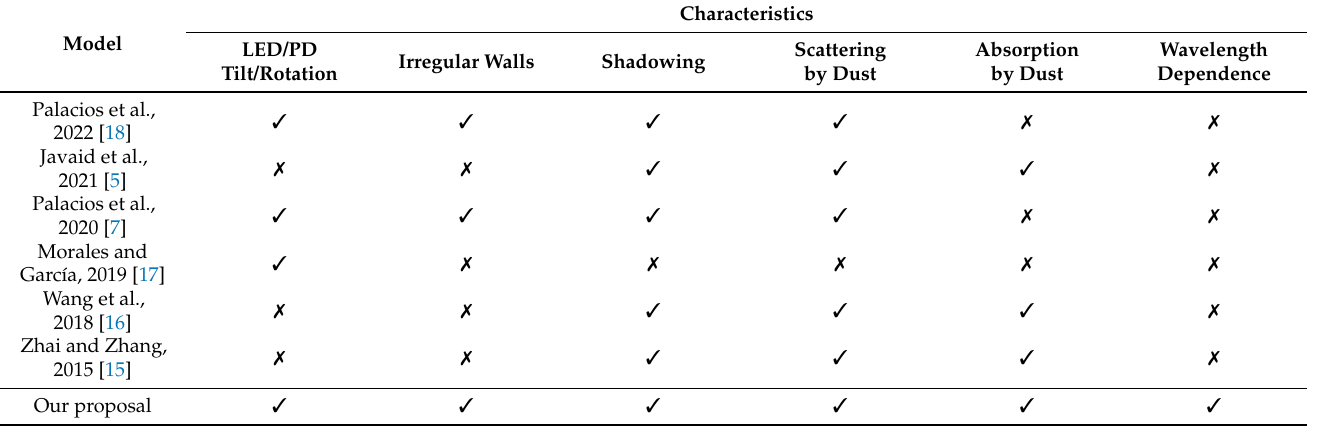
Table 1. Comparison of the proposed model with other state-of-the-art UM-VLC channel